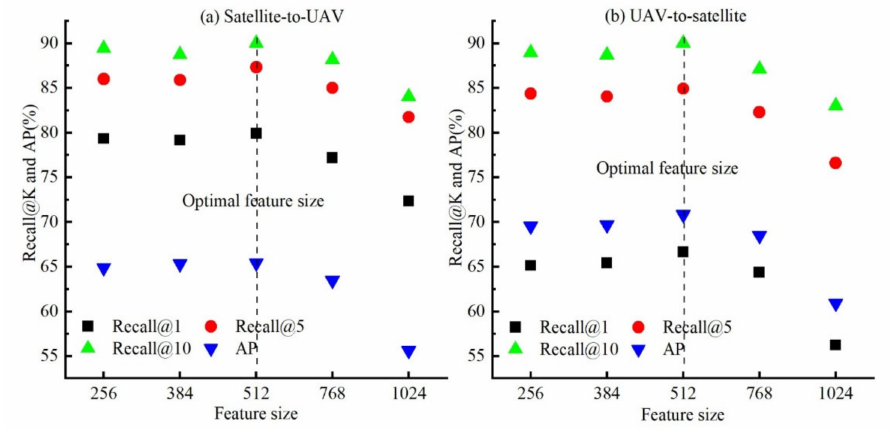
Figure 8. The test results of optimal feature